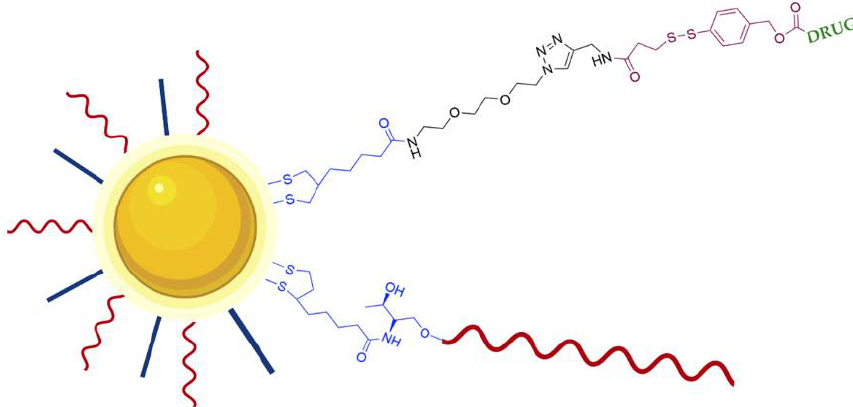
Figure 10. Schematic representation of DNA stabilized GNPs loaded with drug (Doxorubicin or AZD8055). AS1411 (red line) is conjugated through a dithiolane linker (blue). The drug is conjugated through a bifunctional linker composed of an anchoring dithiolane moiety (blue) and self-immolative fragment (brown). The release of the drug is triggered by glutathione breaking the disulfide group present in the self-immolative fragment [102].